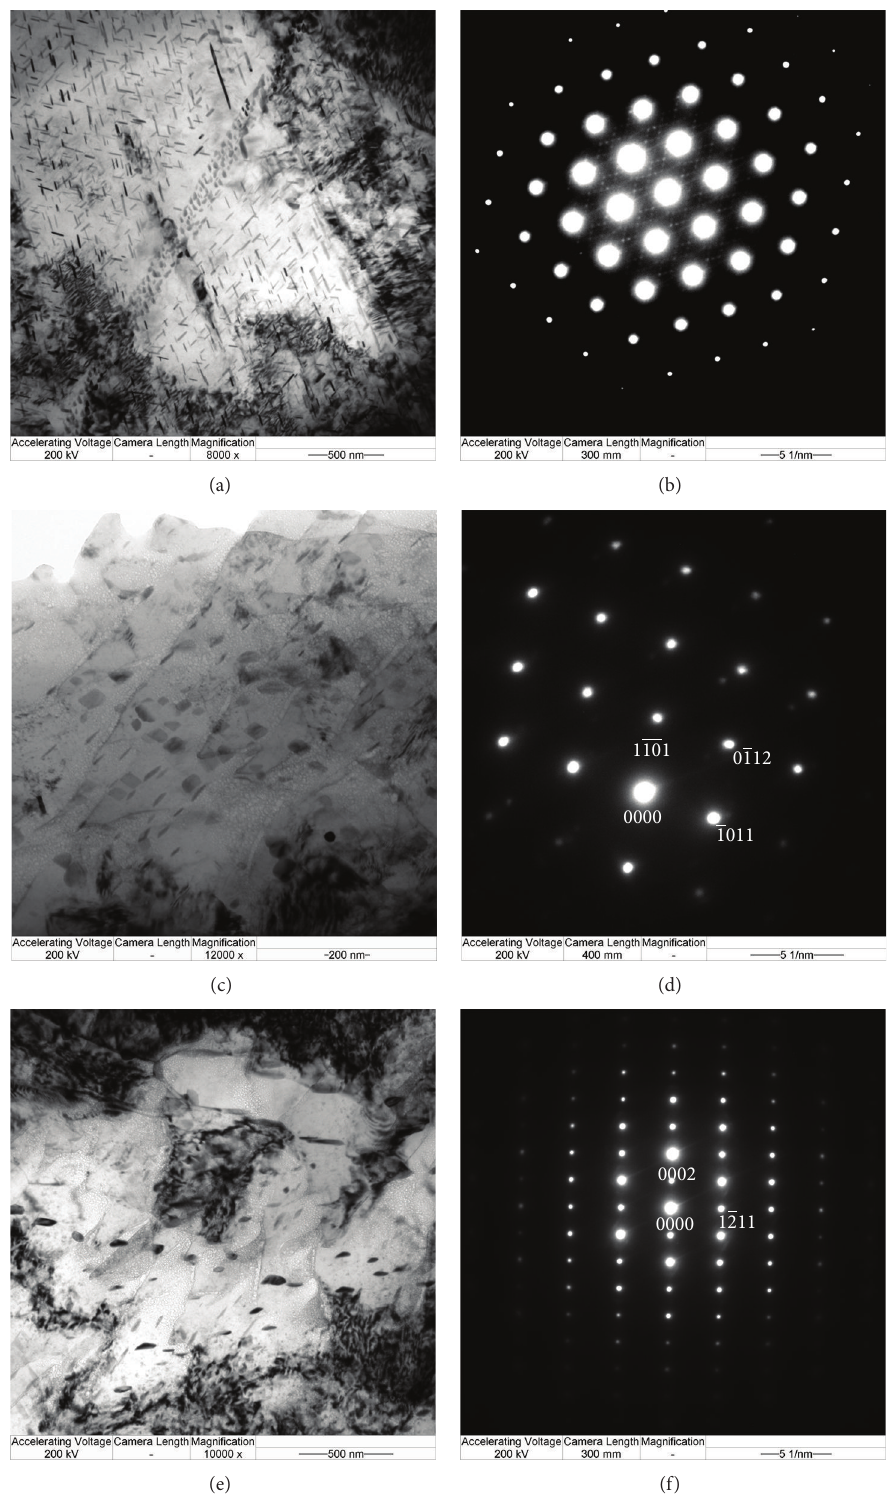
Figure 4: TEM image and electron diffraction pattern aged at 200 ∘ C for 2h: (a) and (b) along [0001] 𝛼 zone axis; (c) and (d) along [0111] 𝛼 zone axis; (e) and (f) along [1120] 𝛼 zone